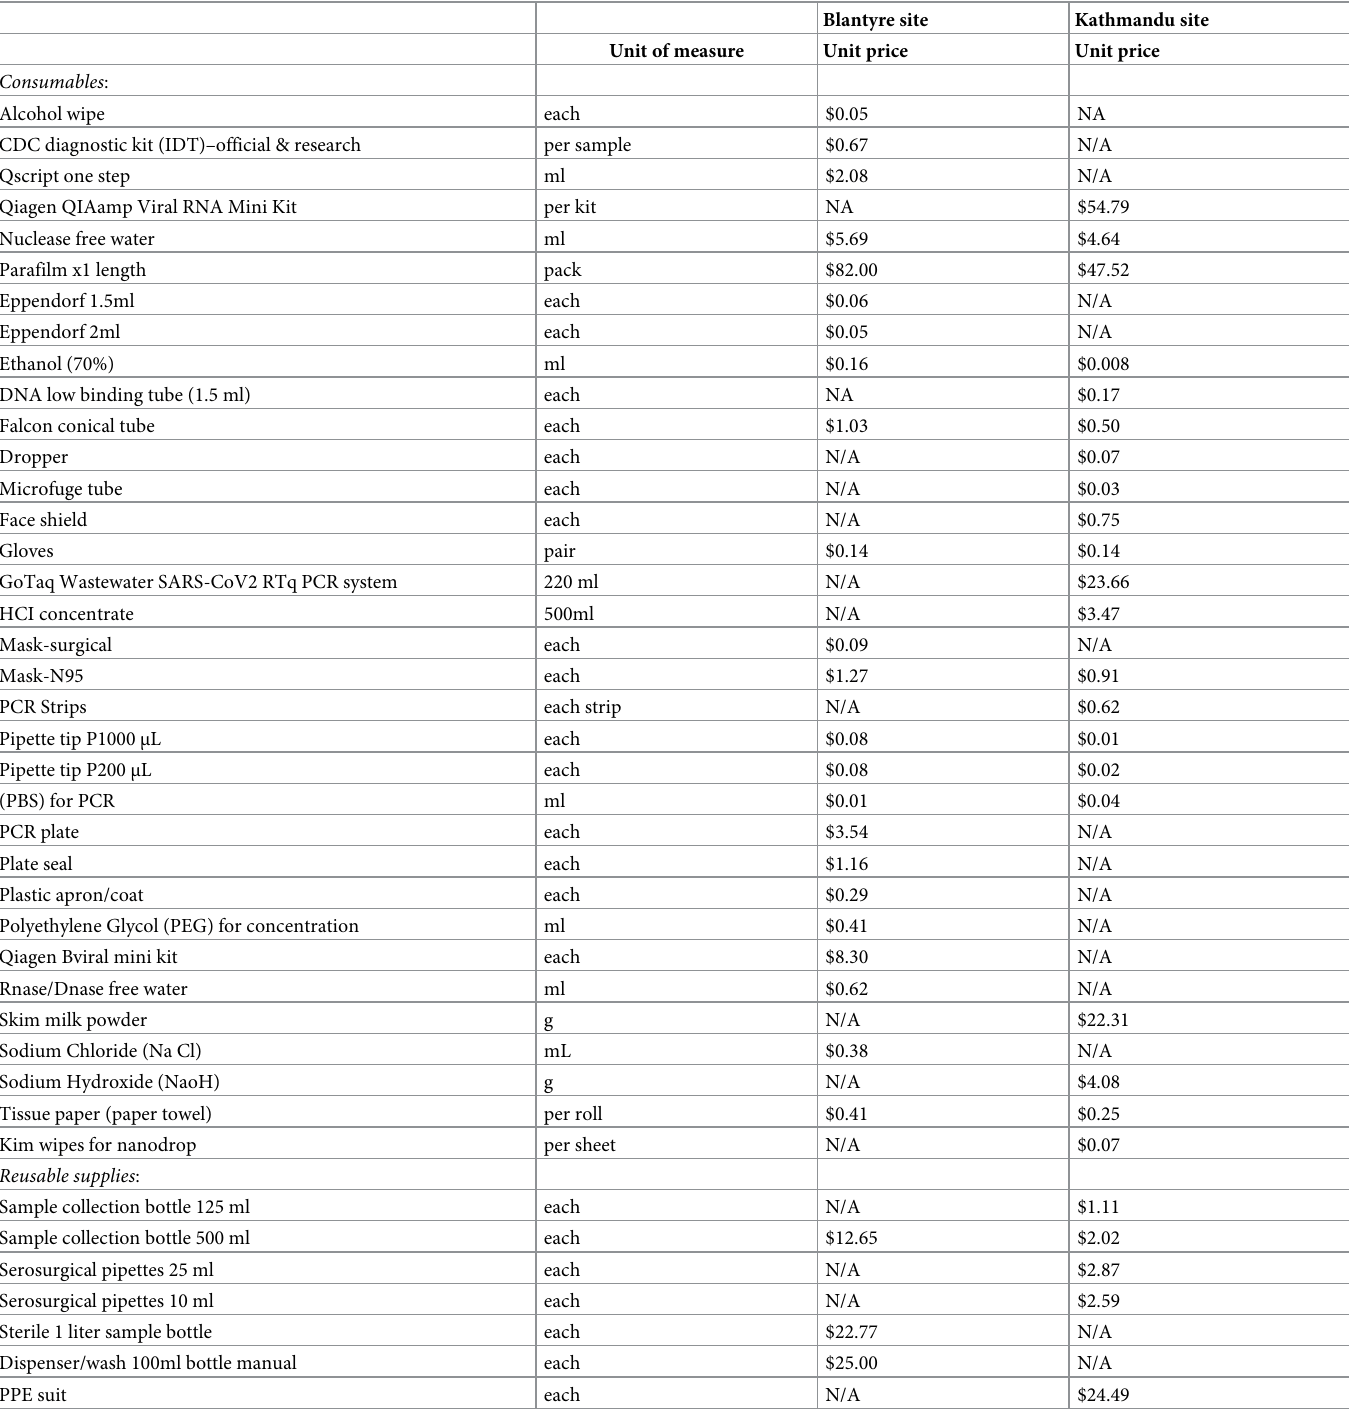
Table 1. Unit prices for consumables and reusable supplies in 2021